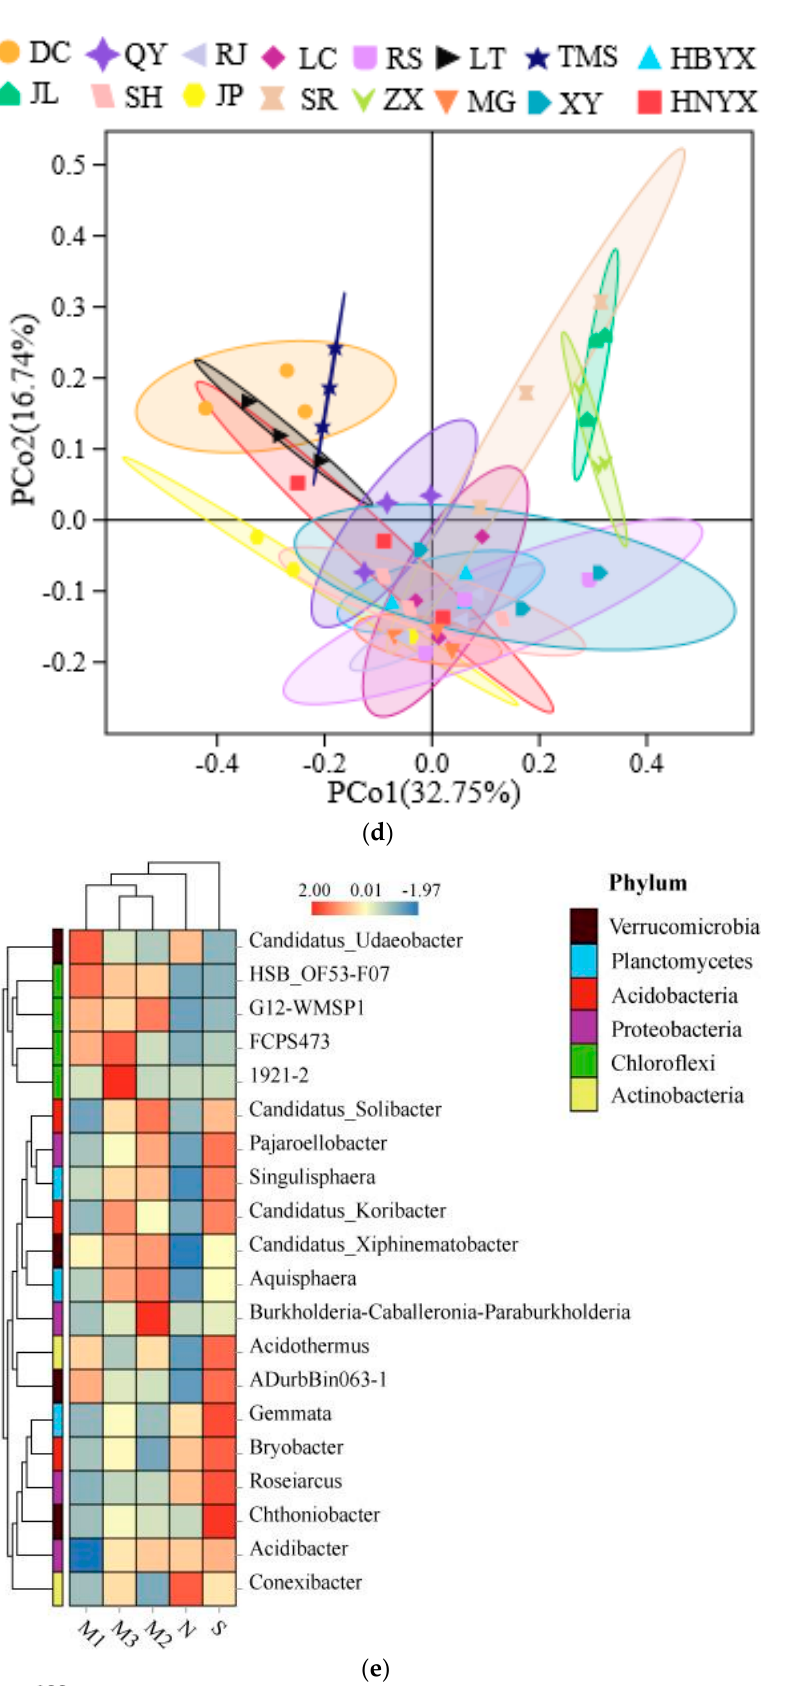
( f ) Figure 3. Ten most abundant phyla ( a ) and genera ( b ) amongst different Chinese fir provenances. Principal coordinate analysis of Bray distances amongst various samples at phylum ( c ) and genus ( d ) levels. Bacterial phylum and genus compositions of rhizosphere soil under different Chinese fir provenances. ( e ) Heat map showing the distribution of the 20 most abundant genera. ( f ) Distribution of the 10 most abundant phyla. N, northern belt; M1, western middle belt; M2, central middle belt; M3, eastern middle belt; S, southern belt. 3.3. Analysis of Biomarkers in the Rhizosphere of Chinese Fir Provenances LEfSe analysis showed that the biomarkers were primarily distributed in the higher latitudes and that the number of biomarkers at a higher latitude was greater than that at lower latitudes (Figure 4). The provenances and corresponding bacteria of relatively higher abundance were as follows: LT: Entotheonellaeota , Subgroup_6 , Chloroflexales , Microtrichales , Rhizobiales_Incertae_Sedis , Pirellula , Gitt_GS_136, Amb_16S_1323 and